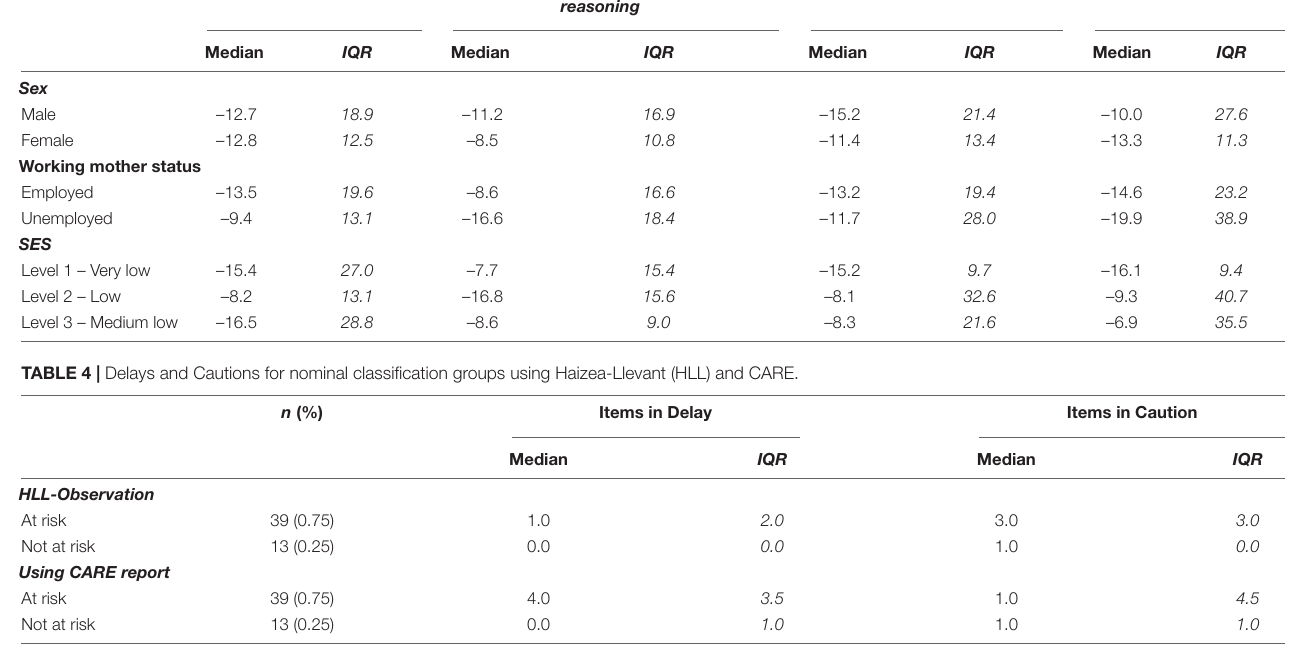
( Median = 4) than the “Not at risk” group ( Median = 0), U = 85.5, p < 0.001, r =